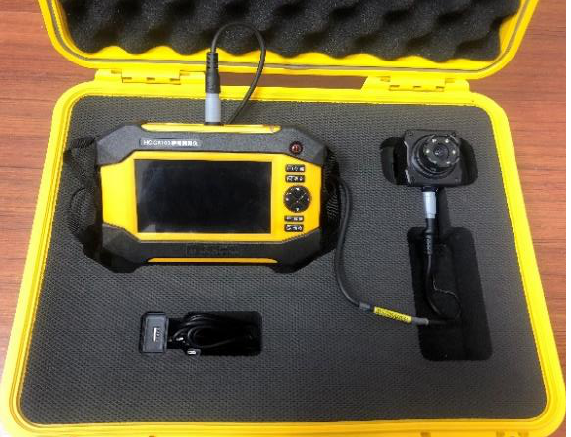
Figure 11. The HICHANCE-CK103 crack width measuring instrument for verification.